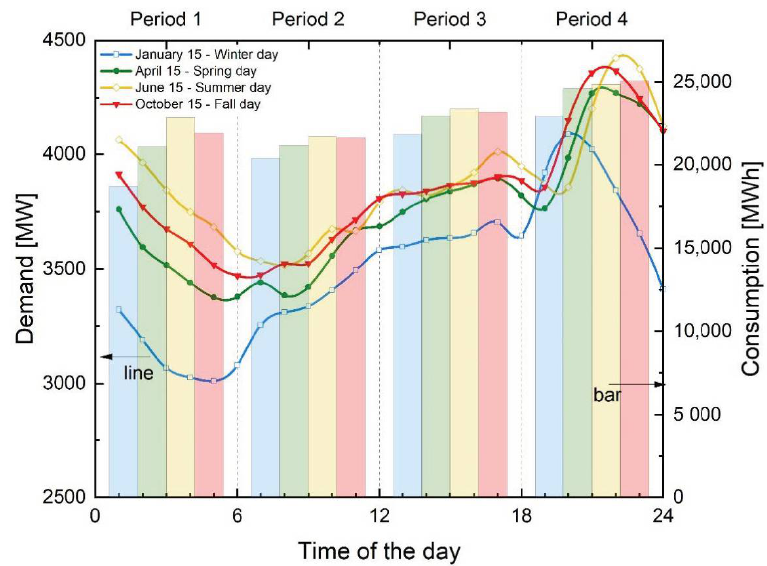
Figure 12. Variation of demand as a function of time of day and required consumption by period for the four days of each season.